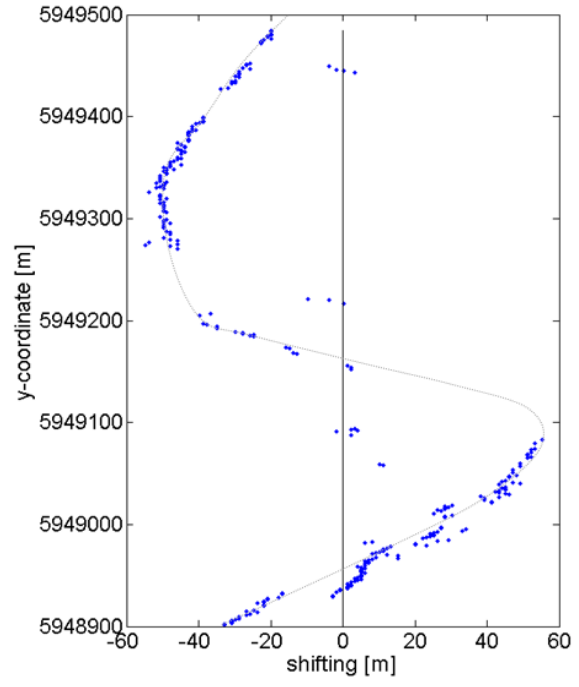
Figure 6. Magnitude of the shifting of the main channel for 2012 in relation to 2010.